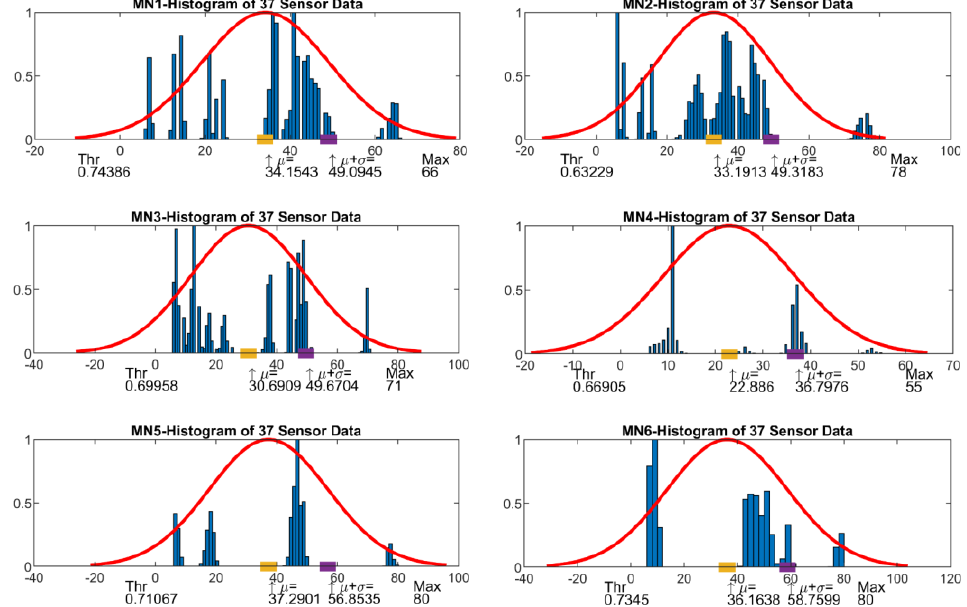
Figure 11 . Histograms for measurements MN1 to MN6 . Figure 11. Histograms for measurements MN1 to MN6.